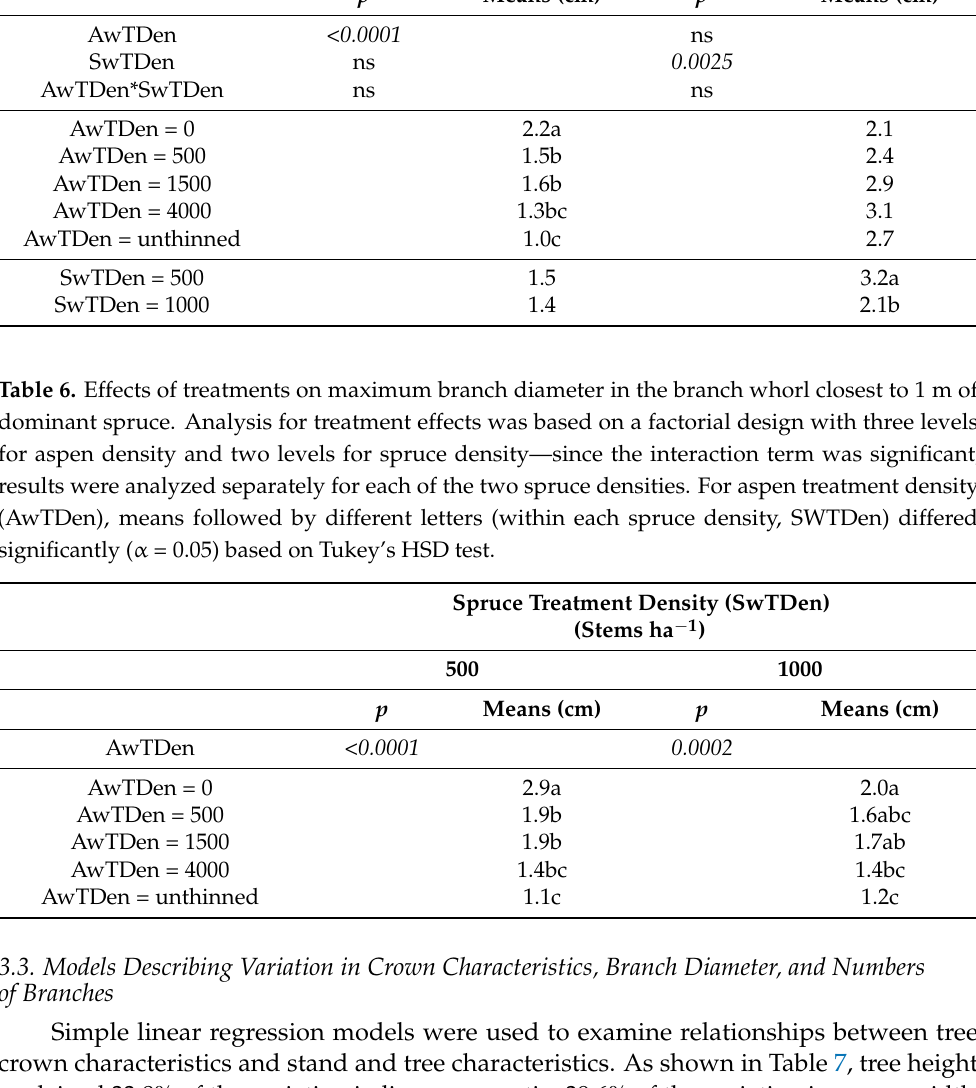
the Whorl Closest to 1 m Height